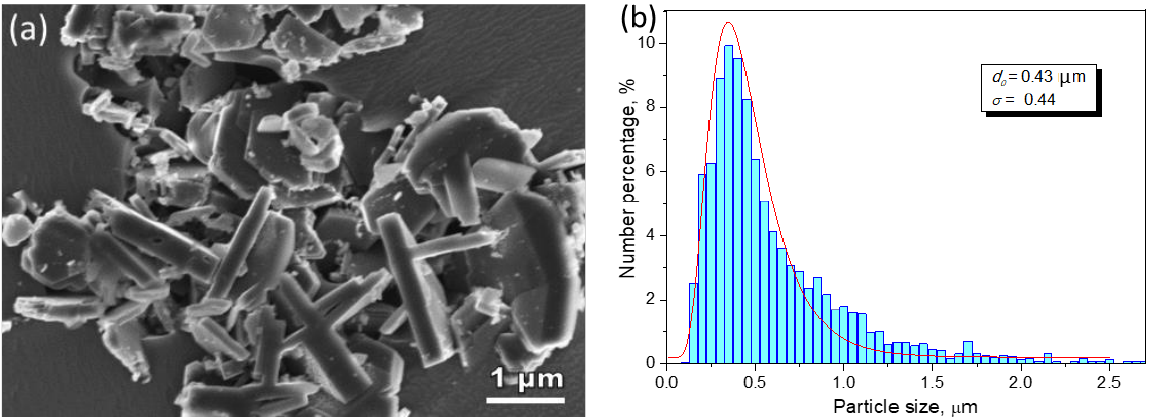
Figure 1. Nature of TiB 2 particles in commercial Al-5Ti-1B grain refiner [54]. ( a ) SEM image showing the typical hexagonal morphology; and ( b ) statistical analysis showing the log-normal size distri- bution with a geometrical mean of 0.43 µ m and a standard deviation of 0.44. The grain refiner was supplied by LSM Co., Ltd.